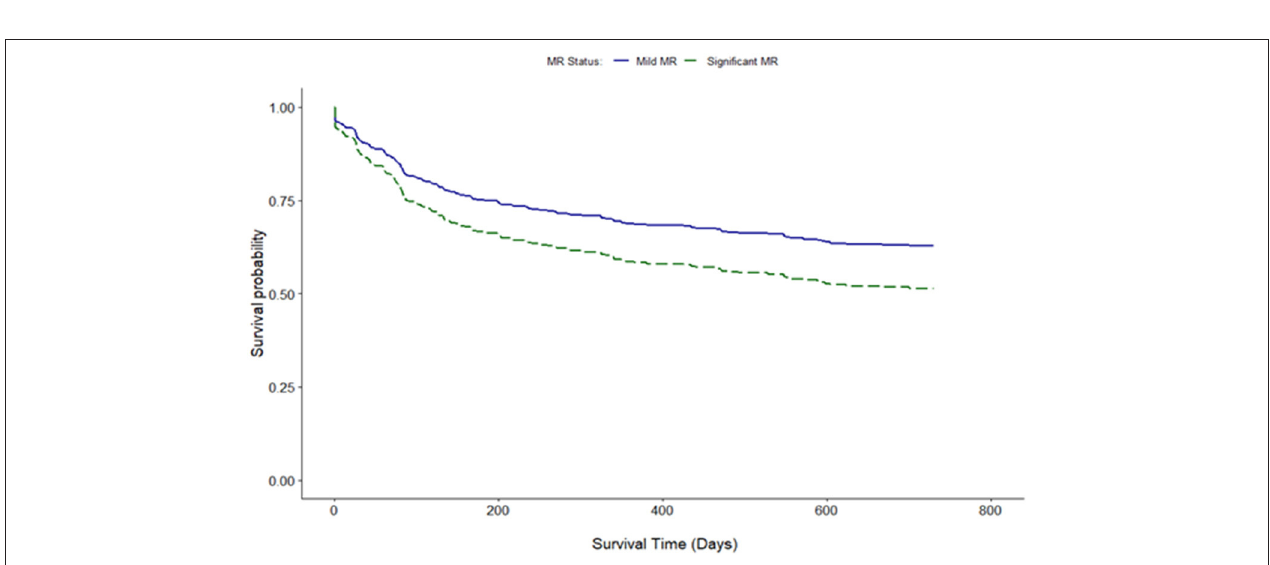
FIGURE 2 | Adjusted survival curve of 2-year all-cause mortality comparing mild and significant MR.